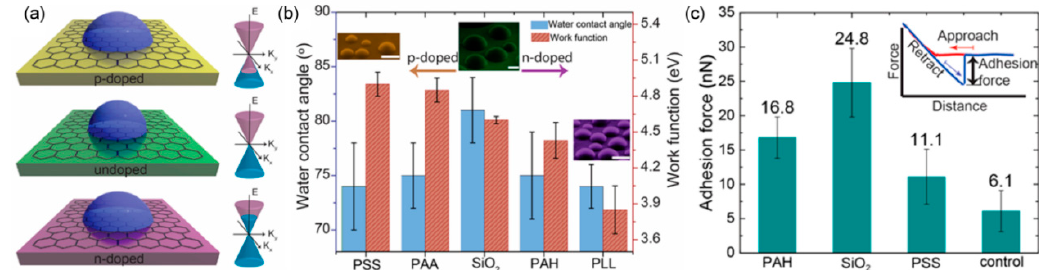
Figure 12. ( a ) Schematic illustrations showing graphene wettability modulation by doping-induced Fermi level shifts. ( b ) Water contact angle (left axis) measured by environmental scanning electron microscopy and the work function (right axis) measured by scanning Kelvin probe microscopy of n-doped (by high molecular weight (HMW) poly(allylamine hydrochloride) (PAH) and poly-L-lysine (PLL)), the p-doped graphene (by HMW poly(sodium 4-styrenesulfonate) and poly(acrylic acid) (PAA)), and undoped graphene on SiO 2 . ( c ) Adhesion force measurements on doped and undoped graphene samples using an octadecyltrichlorosilane-coated silicon AFM probe. Hydrophilic SiO 2 / Si was used as a control substrate and showed the lowest adhesion force. Reprinted from Ref. [96], Copyright 2016, with permission from ACS publications.